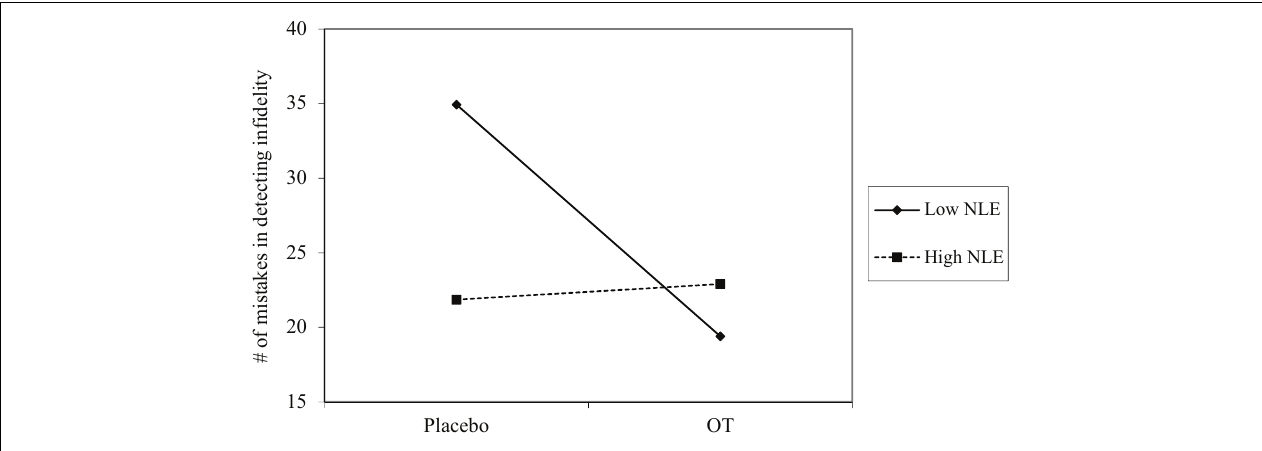
FIGURE 5 | Accuracy in detecting infidelity (number of mistakes) as a function of OT administration and early life stress (NLE). High OT was not linked with accuracy among people with high early life stress (i.e., not seeing flaws), but was linked with higher accuracy among people with low early life stress and safer environments (i.e., greater sensitivity to social